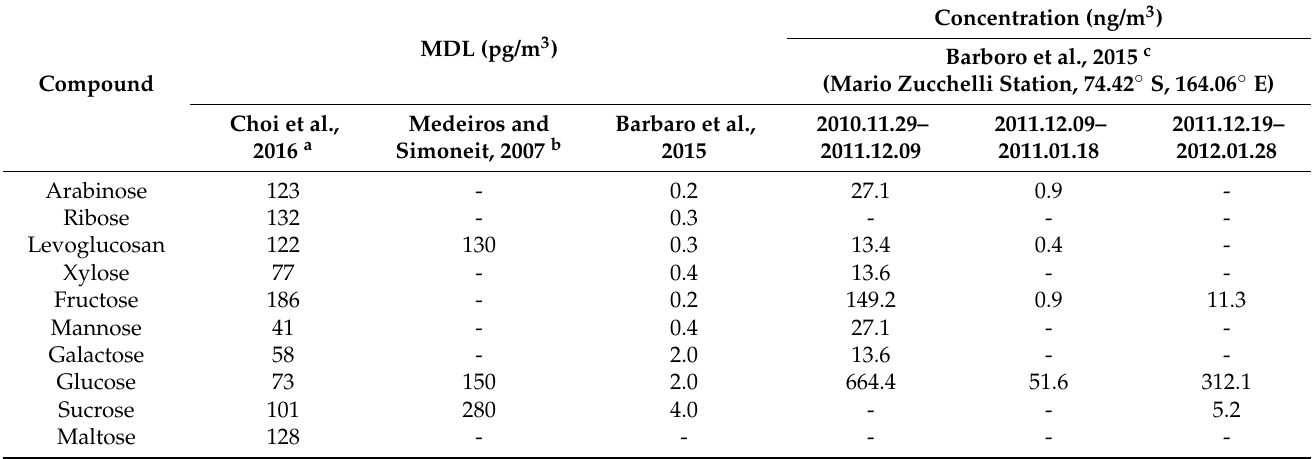
Table A1. MDLs measured using MS and the concentrations of saccharides in PM 10 in Antarctic regions measured in previous studies.